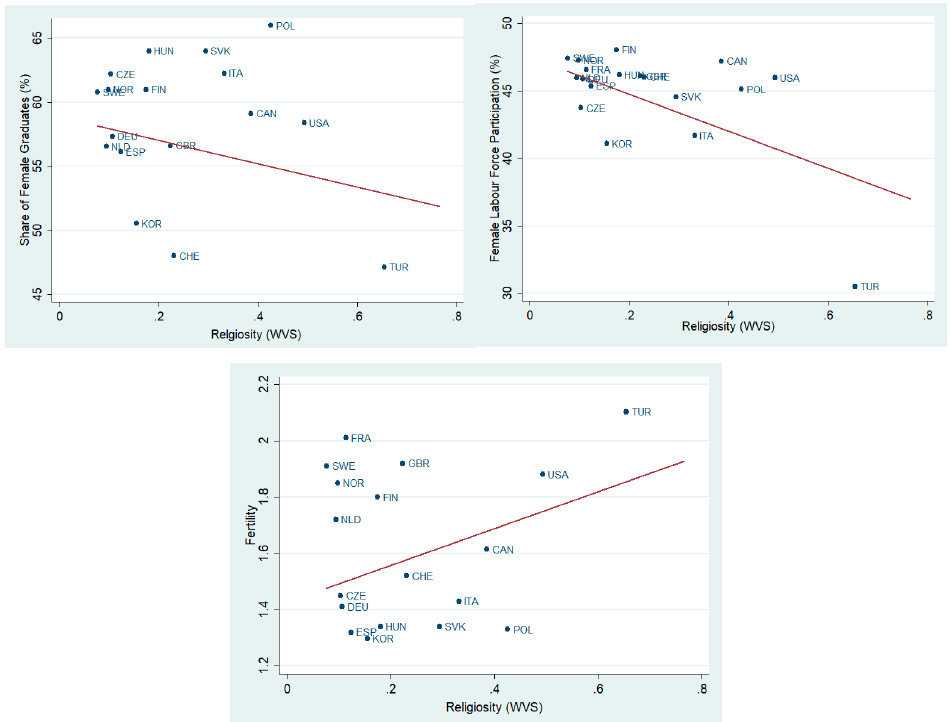
Figure A4. Women in the LM and HE and